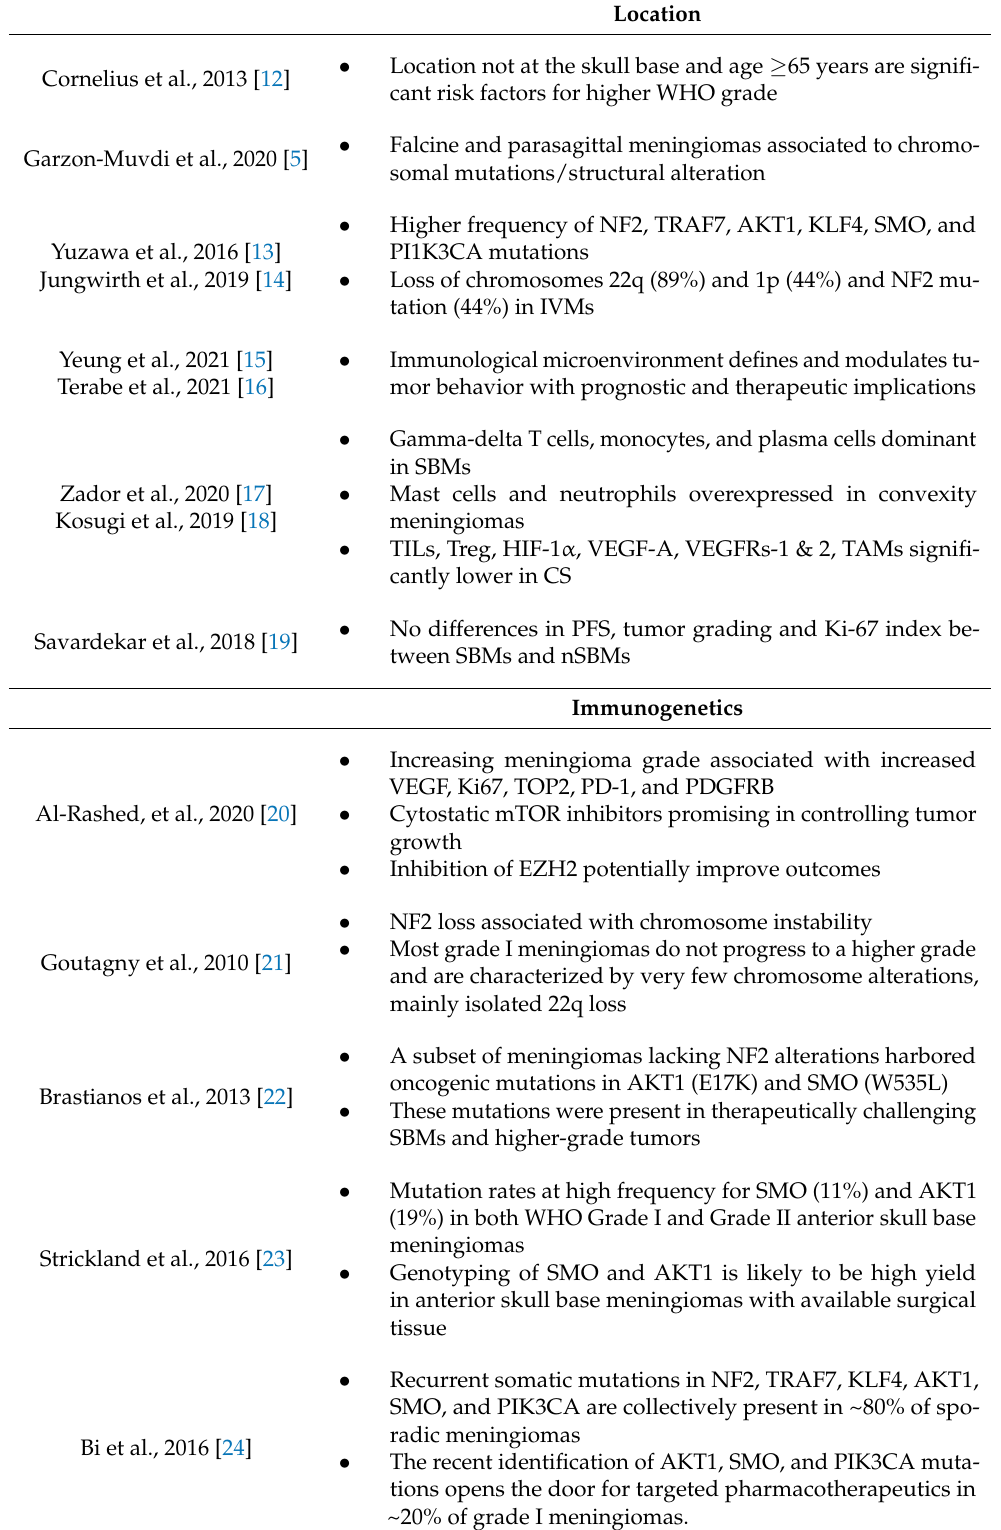
Table 1. Result of systematic review and summary of main data from selected articles.